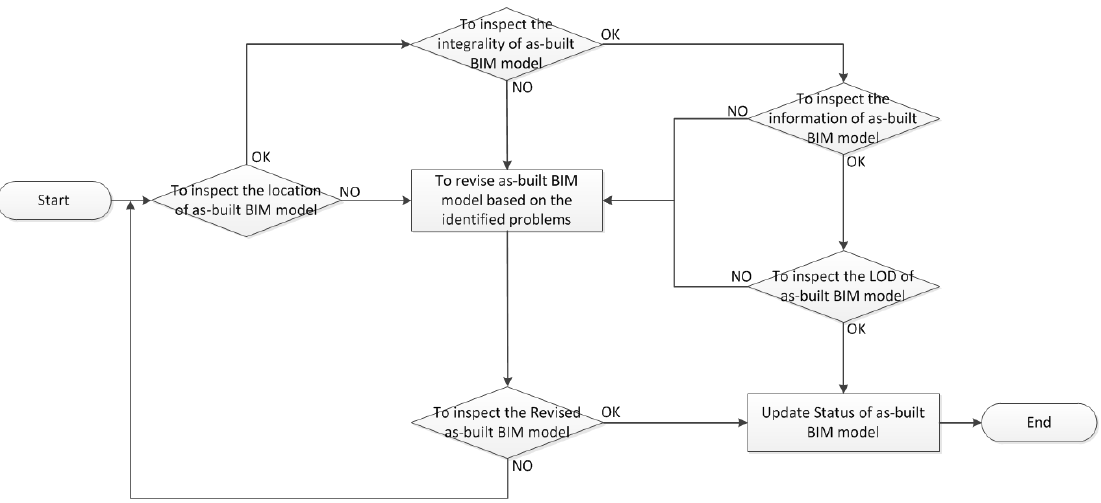
Figure 3. The process of BIM models inspection mechanism during pre ‐ operation phase.